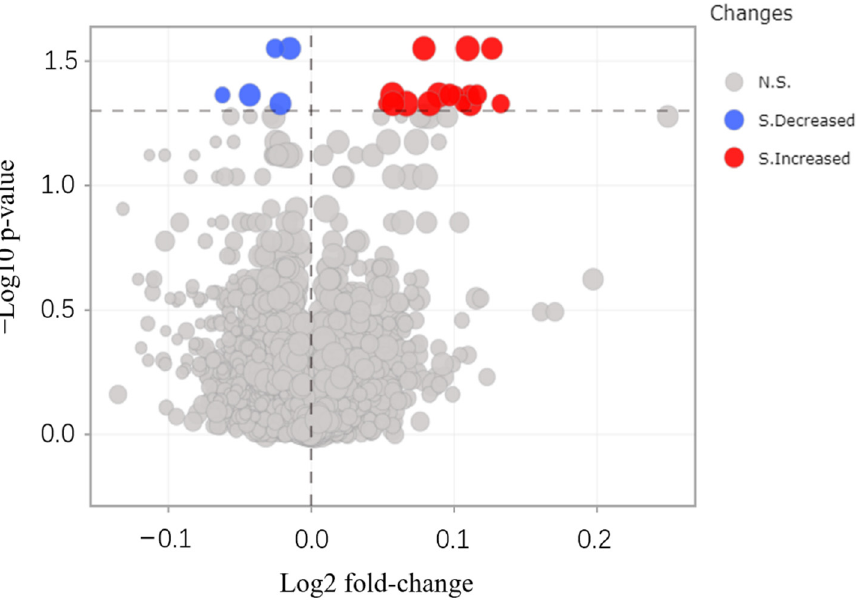
Figure 5. Volcano plot to detect differential proteins of purple-red cultivars compared with white- yellow cultivars. Red refers to upregulated proteins, and blue refers to downregulated proteins. Among all identified differential proteins (Table 2), 11 upregulated proteins (A0A4S4EJX1, A0A4S4D3X1, A0A4S4DAL3, A0A4S4EPH5, A0A4S4DHY3, A0A4S4DU30, A0A4S4DZ53, A0A4S4ES74, A0A4S4EXN0, A0A4S4EYN1 and A0A4S4EZG3) played main roles in